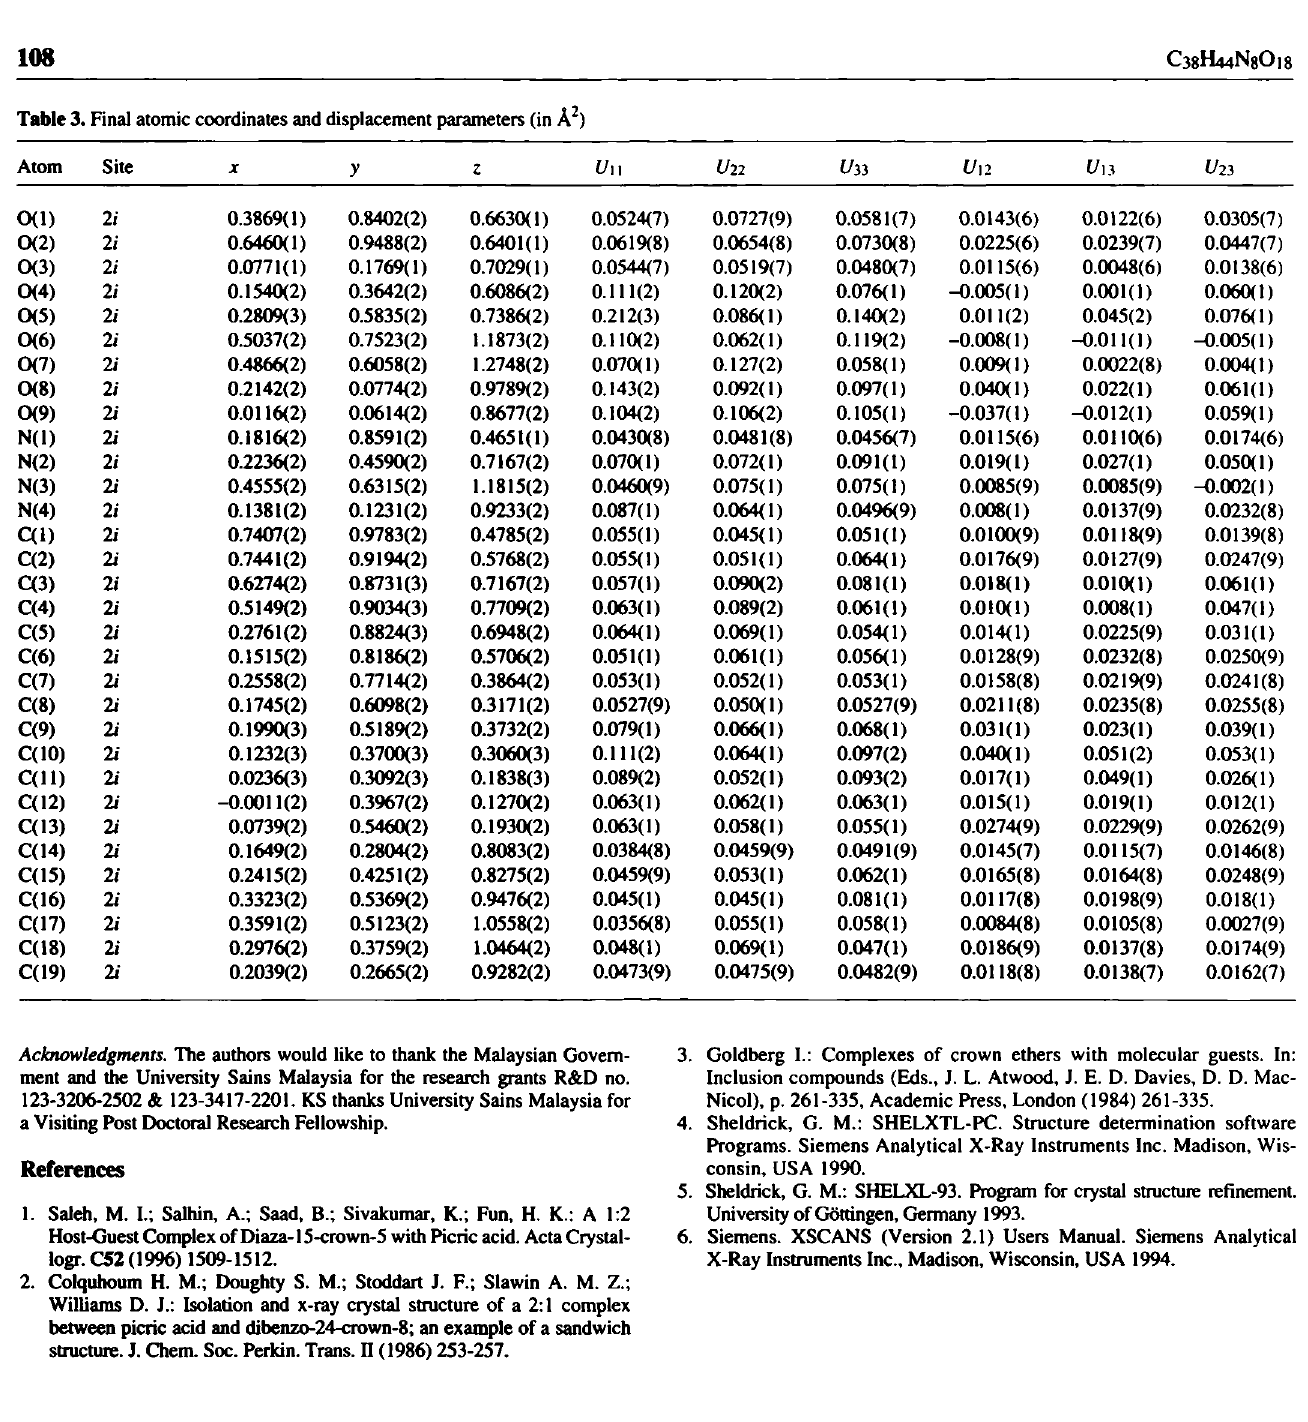
Table 3. Final atomic coordinates and displacement parameters (in Â 2